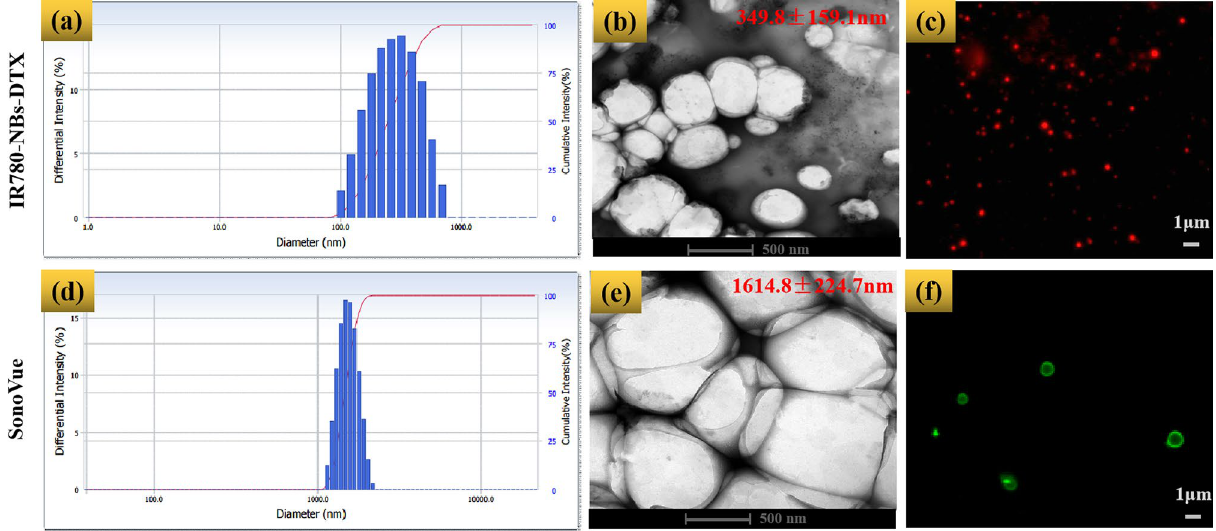
Figure 4. The characteristics of IR780-NBs-DTX and SonoVue. ( a , d ) The intensity distribution of IR780-NBs- DTX and SonoVue. ( b , e ) IR780-NBs-DTX and SonoVue were assessed via TEM. ( c , f ) IR780-NBs-DTX and SonoVue were detected by